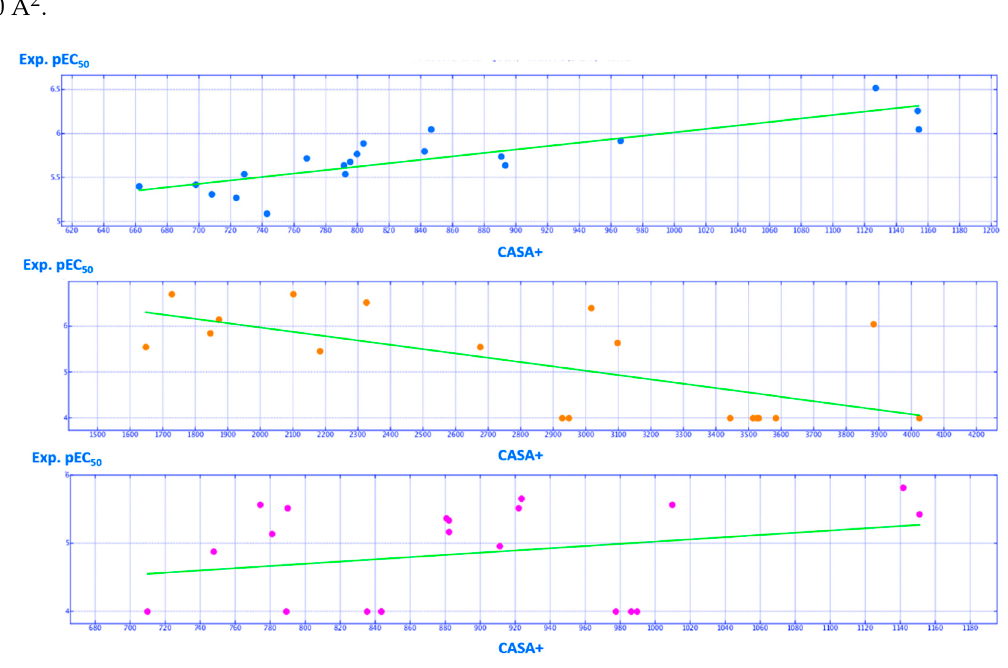
Figure 19. Distribution of the experimental (Exp.pEC 50 ) potency values of the training set compounds based on the CASA + descriptor (Å 2 ). Hybrid derivatives, tetrahydropyridopyrimidines and cyanoquinolines are reported as cyan, orange and magenta spheres, respectively.